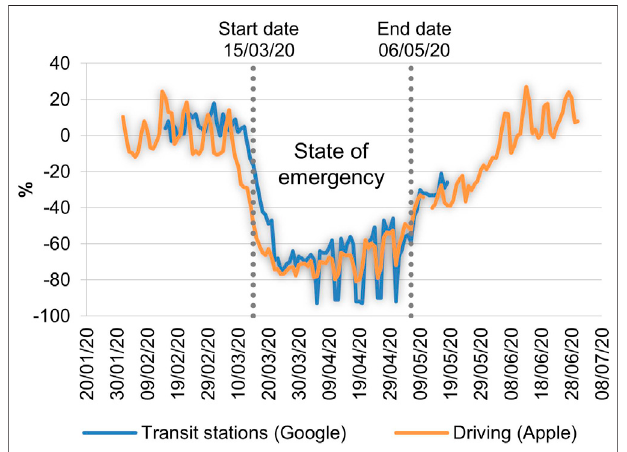
FIGURE 3 | Changes in mobility data (%) in Serbia during the period February – June2020.Theverticallinesshowthestartandendoftherestrictive measures period.